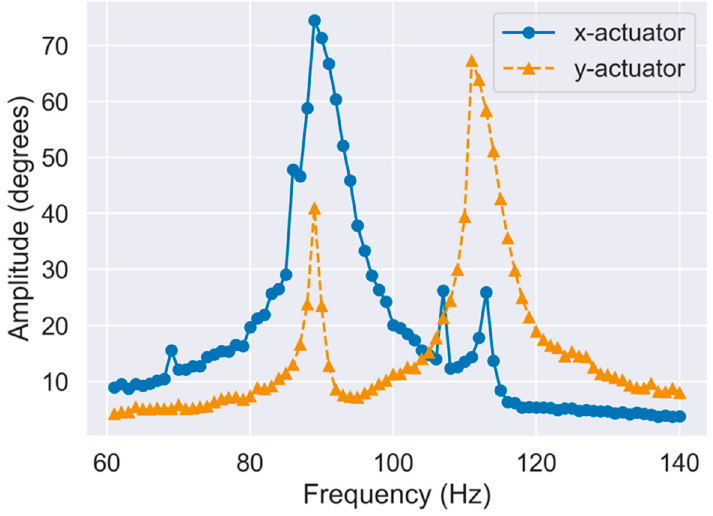
Figure 11. Frequency response of fabricated scanner.